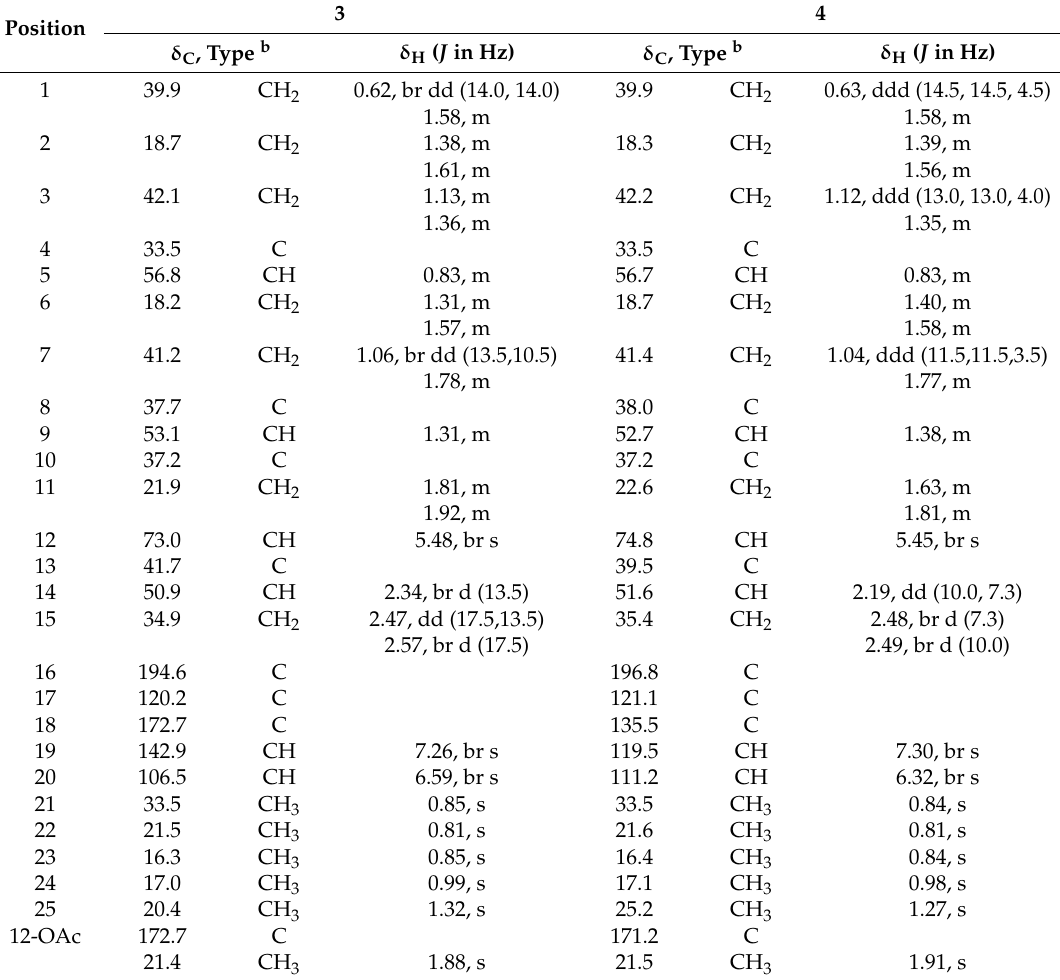
Table 1. 1 H- and 13 C-NMR data (500 and 125 MHz) for compounds 3 and 4 a, b